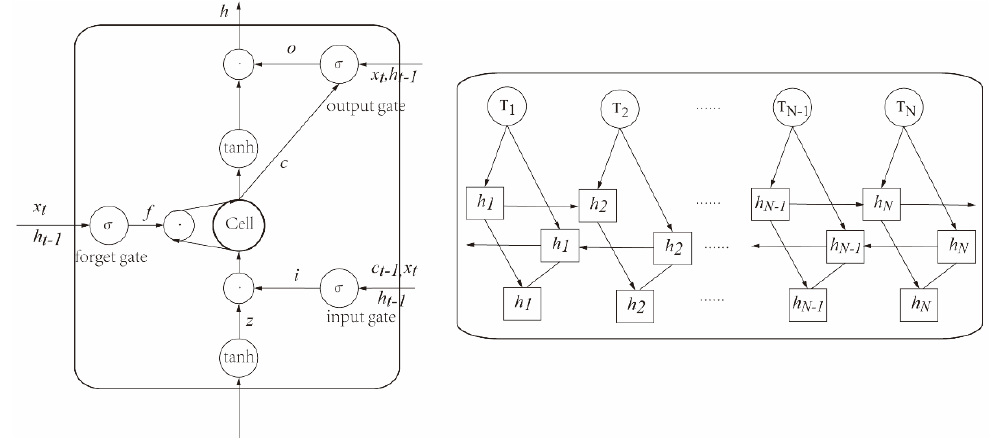
Figure 5. Neuron structure of LSTM.